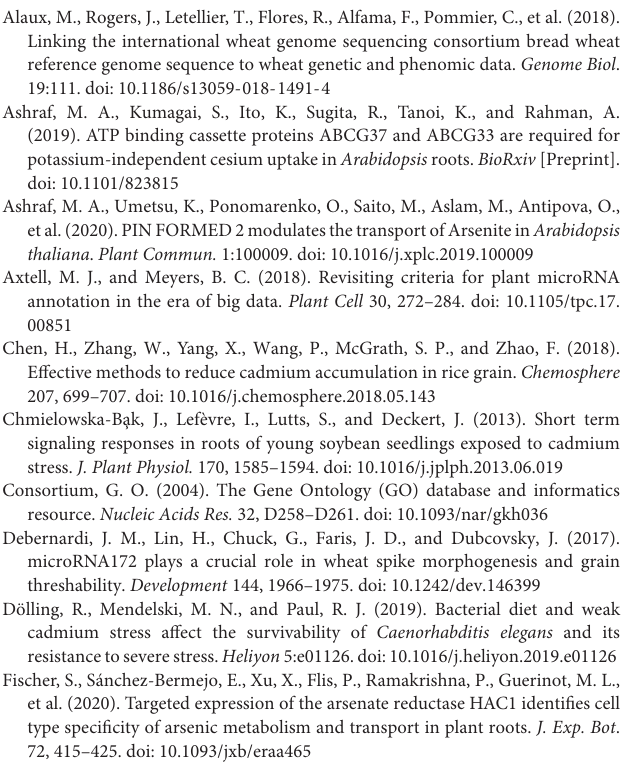
Supplementary Table 1 | Counts of known mature miRNA related to wheat cadmium accumulation. Supplementary Table 2 | Counts of pri-miRNA related to wheat cadmium accumulation.